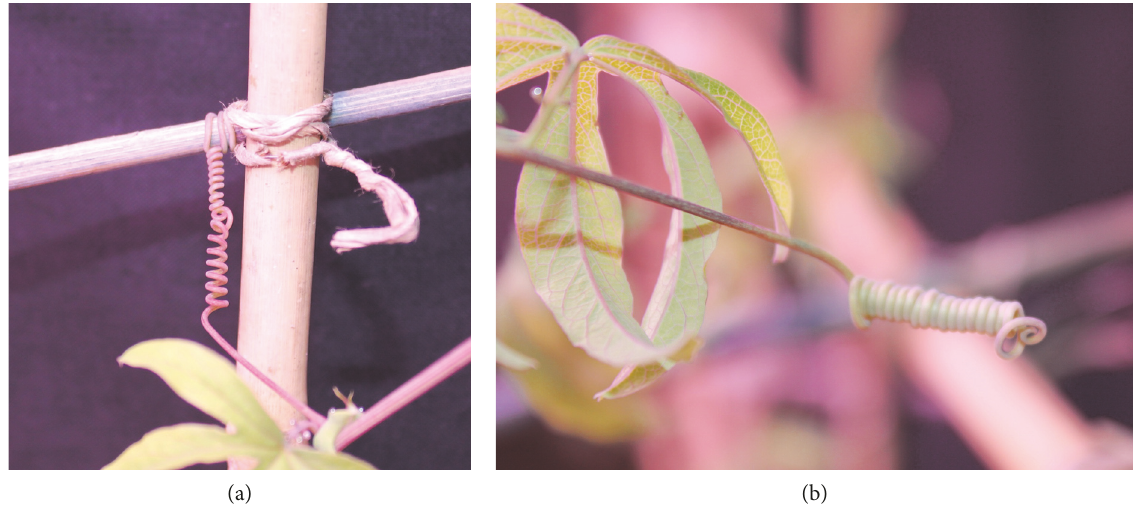
Figure 1: Tendril free coiling: (a) grasped tendril; (b) nongrasped